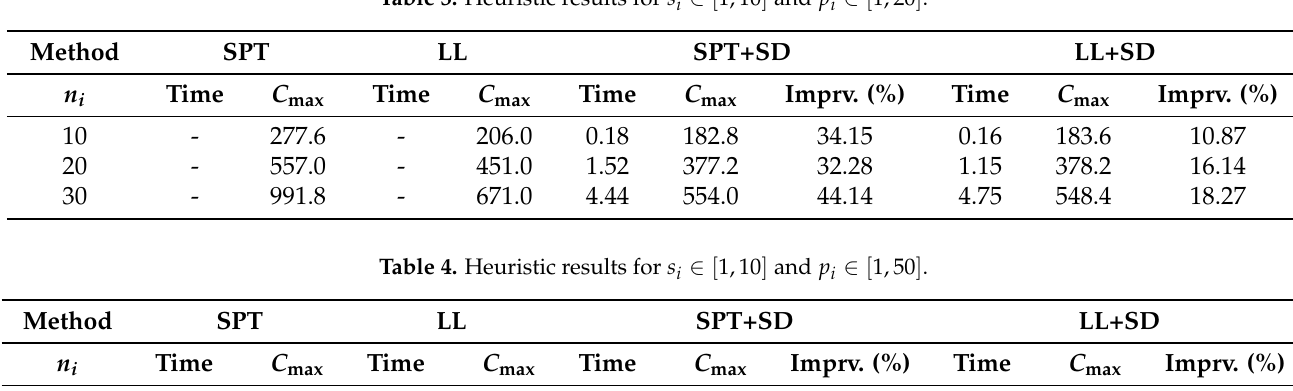
Table 3. Heuristic results for s i ∈ [ 1,10 ] and p i ∈ [ 1,20 ] .